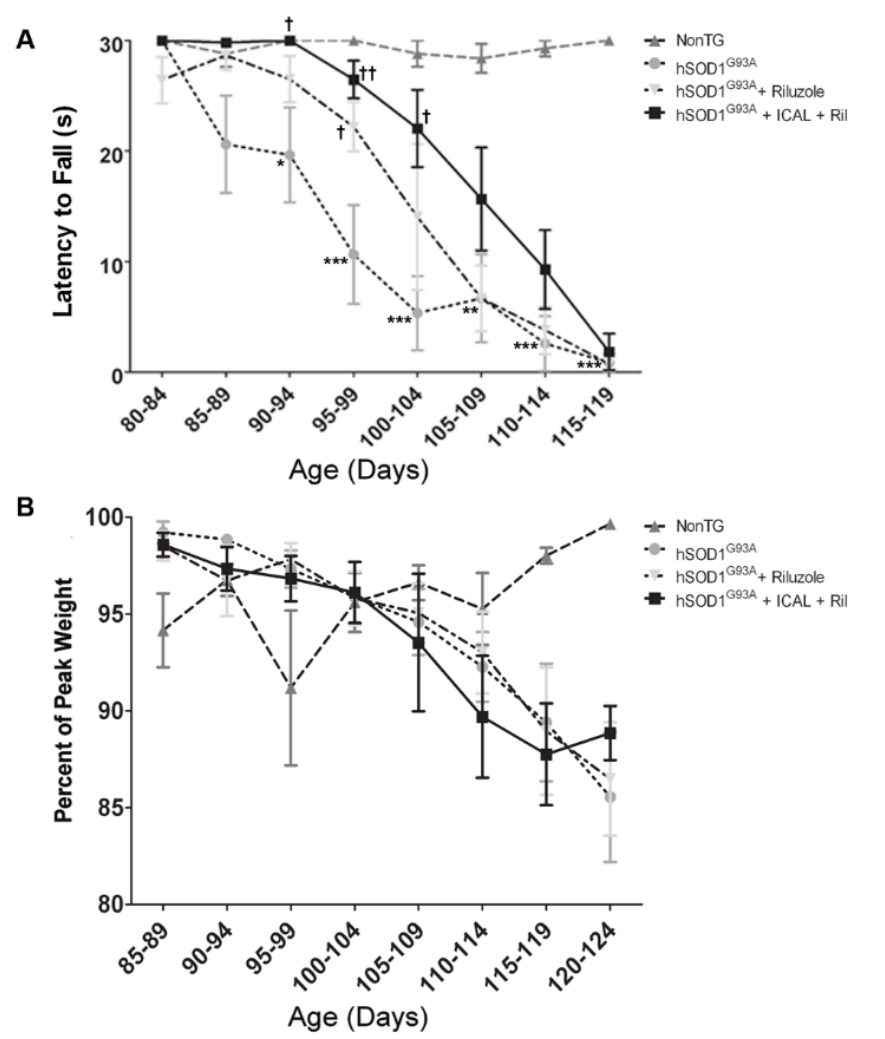
Figure 7. Treatment with Immunocal ® and riluzole diminishes the decline in grip strength in hSOD1 G93A mice. ( A ) The PaGE hanging wire test expressed as latency to fall at indicated ages ( n = 8); ( B ) body weight of wild-type and hSOD1 G93A mice expressed as percent of peak body weight. All data are represented as the mean ± SEM. *** indicates p < 0.001 compared to NonTG; ** indicates p < 0.01 compared to NonTG; * indicates p < 0.05 compared to NonTG; †† indicates p < 0.01 compared to untreated hSOD1 G93A mice; and † indicates p < 0.05 compared to untreated hSOD1 G93A mice (one-way ANOVA with a post hoc Tukey’s test conducted for each time